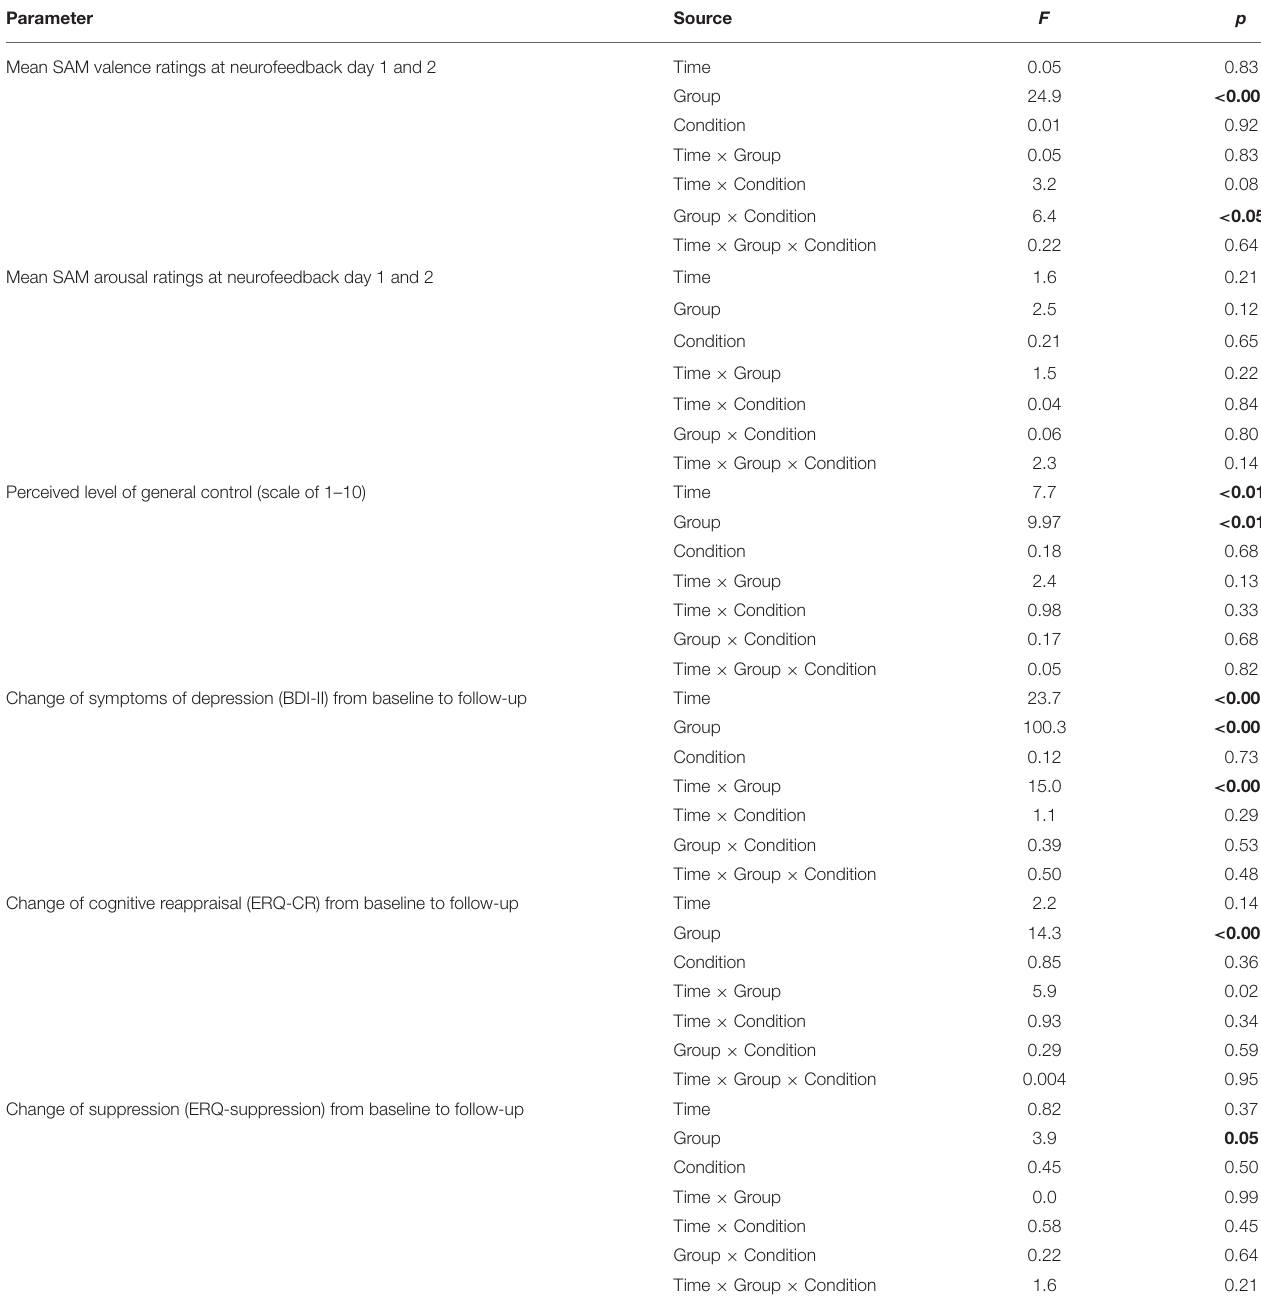
TABLE 2 | Repeated-measures ANOVAs of change from baseline to follow-up (BDI-II and ERQ) and change of general perceived control across neurofeedback trainings. Parameter Source F p Mean SAM valence ratings at neurofeedback day 1 and 2